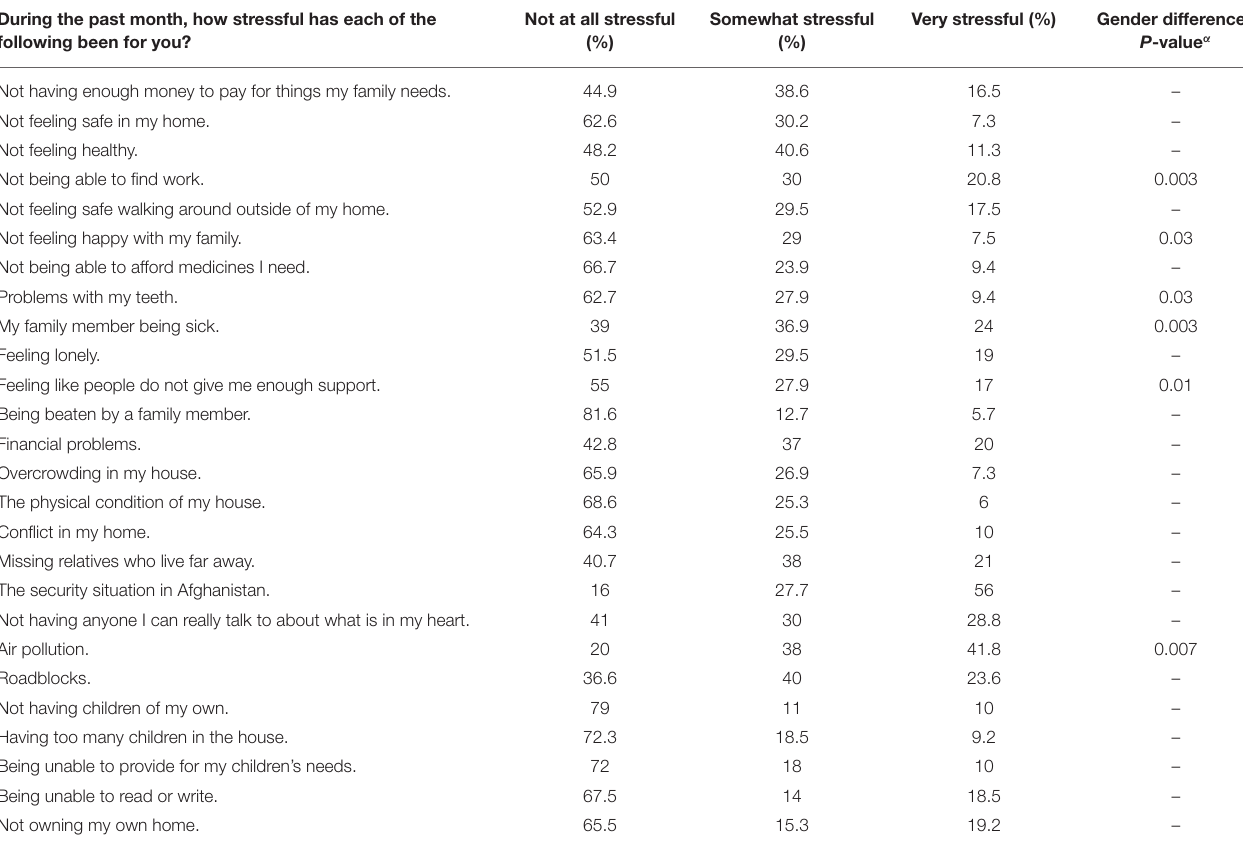
Not at all stressful Somewhat stressful Very stressful (%) Gender differences P -value α (%) (%)